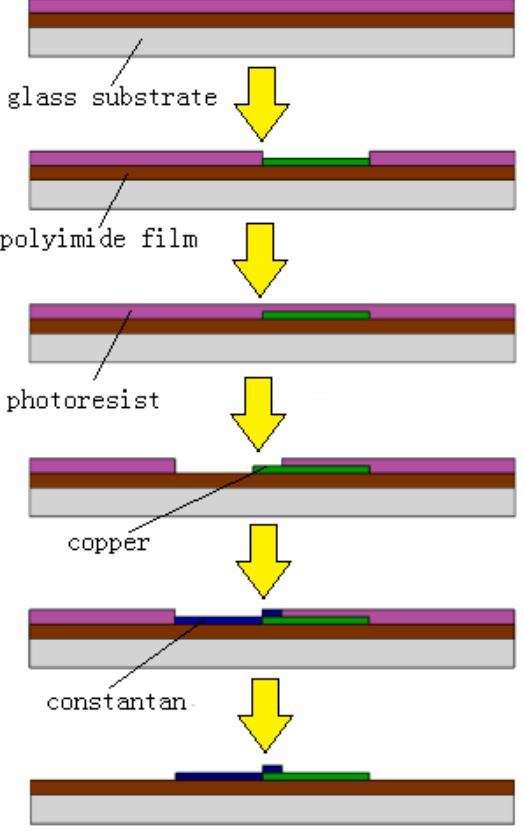
Figure 11. Fabrication-process diagram of the sensor.